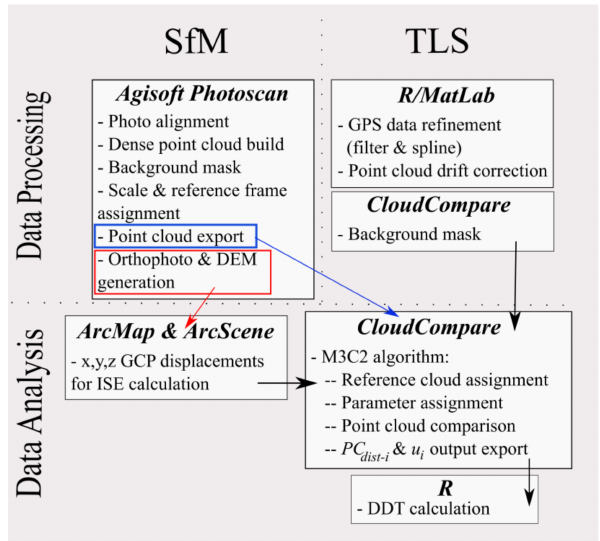
Figure 3. Processing and analysis workflow for aerial photography data with structure-from-motion multi-view stereo photogrammetry (SfM) processing or TLS survey data. The headings in each box refer to the software program used for the listed workflow steps. Red and blue arrows are used to differentiate the workflow associated with the products of SfM processing. DDT = Deterioration detection threshold, ISE = inter-survey error, M3C2 = Multiscale Model-to-Model Cloud Comparison algorithm, PC dist-i = distance between point clouds at core points, u i = uncertainty in PC dist-i